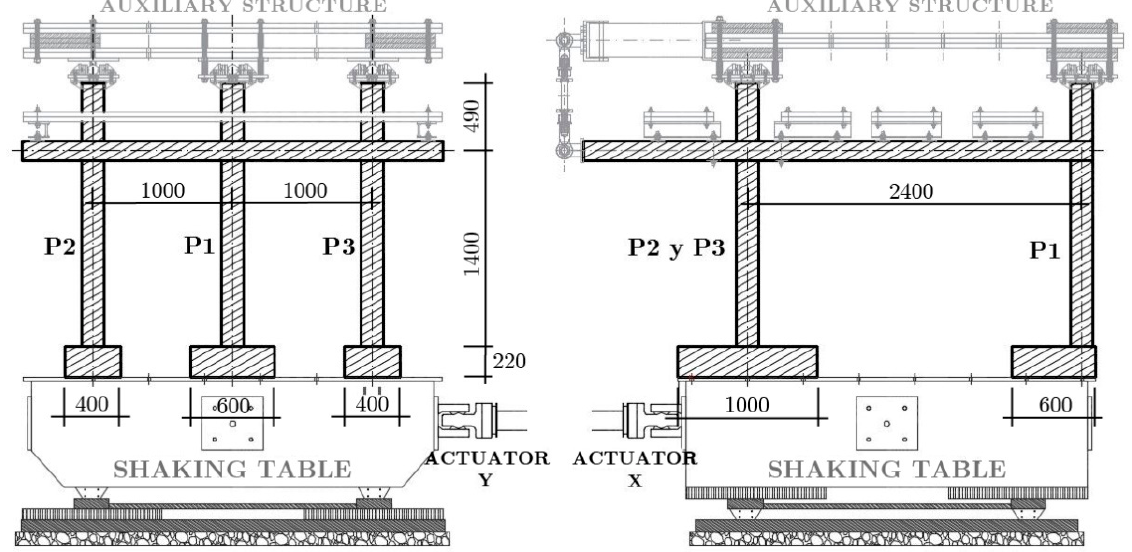
Figure 2. Elevations of the specimens installed on the shaking table. Dimensions in mm. 117